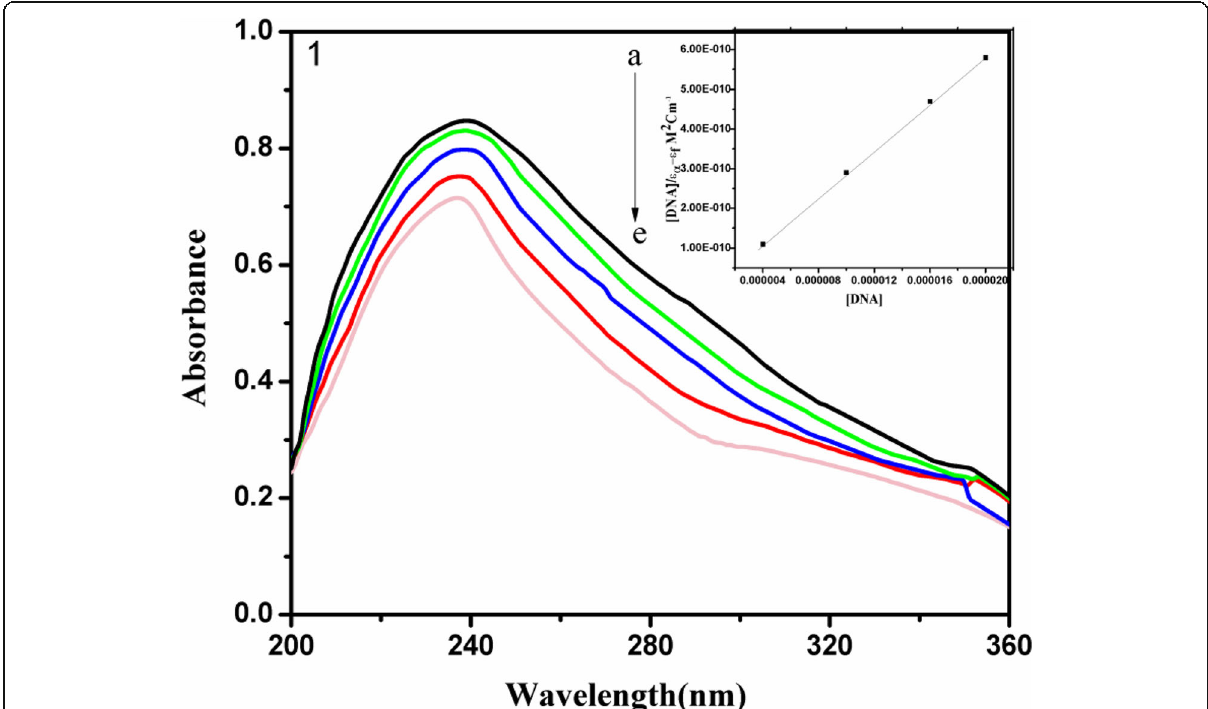
Fig. 1 Absorption spectra of compound (1) (1 × 10 − 4 M) in the presence of increasing amounts of Ct-DNA (1.2 – 3.0 × 10 − 5 M). The inset is plot of [DNA]/( ε a − ε f ) vs [DNA] for the titration of DNA to compound